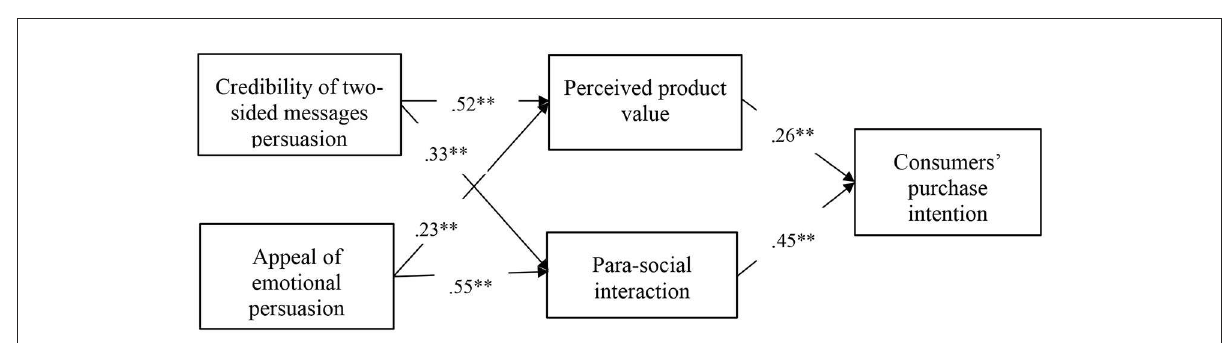
FIGURE2 Standardized coefficients for the hypothesized model. ** = p <